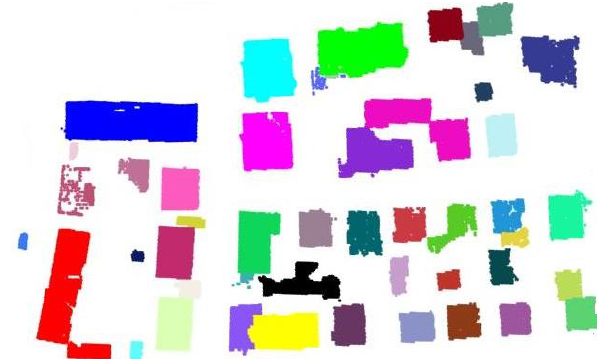
Figure 9. Detected buildings by the proposed method